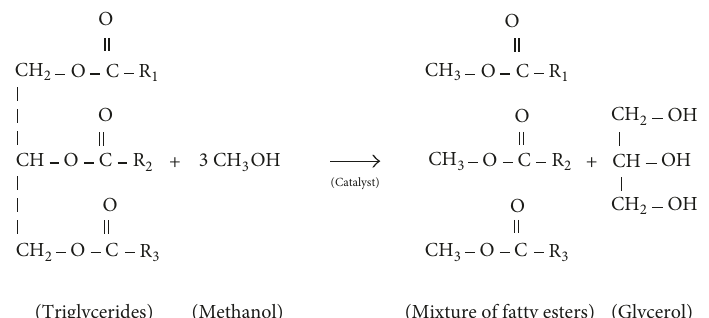
Figure 1: Transesterification reaction